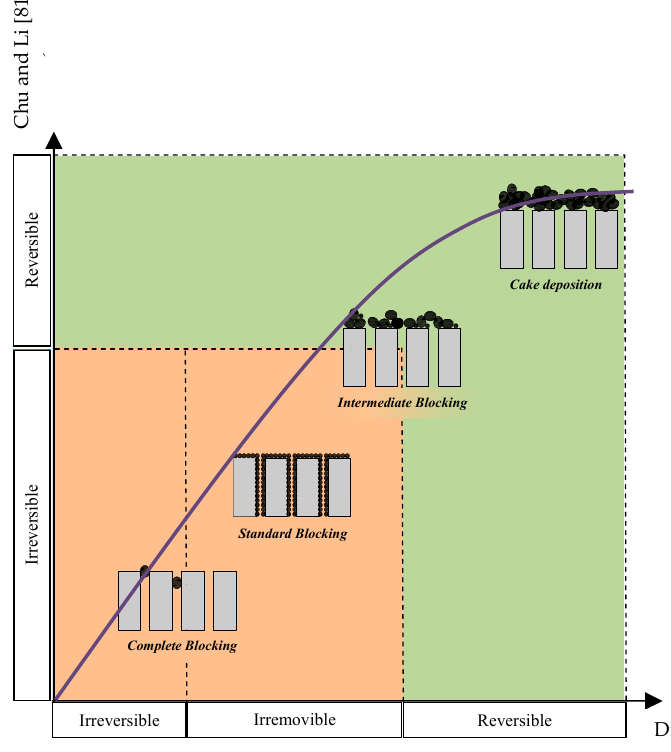
Figure 1. Reversibility of different fouling mechanisms.